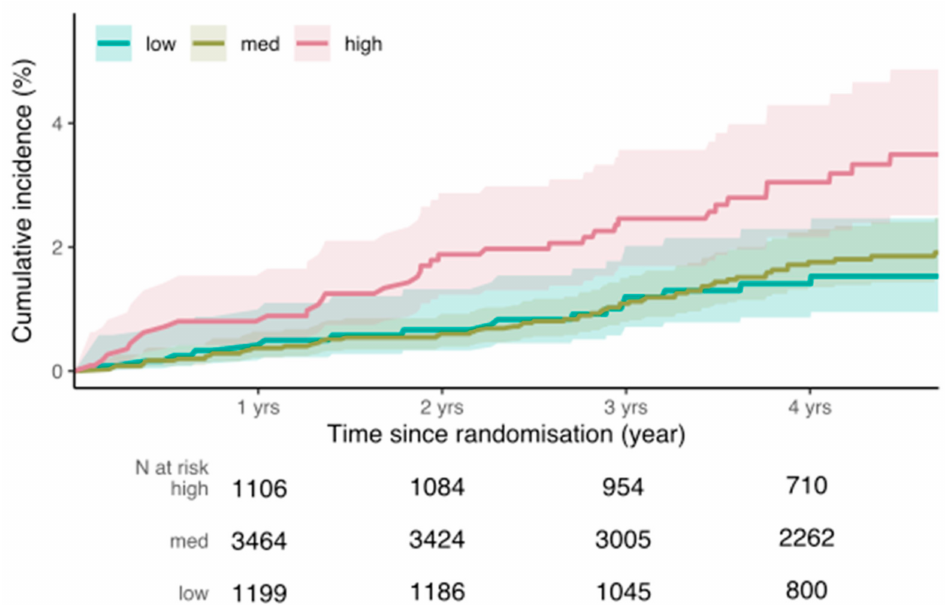
Figure 2. Competing risk survival curves for incident breast cancer according to PRS groups. The PRS distribution was categorized by quintiles (Q) of the distribution into three groups: low-risk (Q1, green), medium-risk (Q2–4, brown) and high-risk (Q5, red). Competing risk estimates of the cumulative incidence were calculated for each group, adjusting for the following covariates: family history of BC (first-degree blood relatives), treatment (aspirin/placebo), age at enrolment, number of children, alcohol consumption, body mass index (BMI) at enrolment, and use of estrogen or estrogen/progesterone hormone replacement therapy (HRT) at